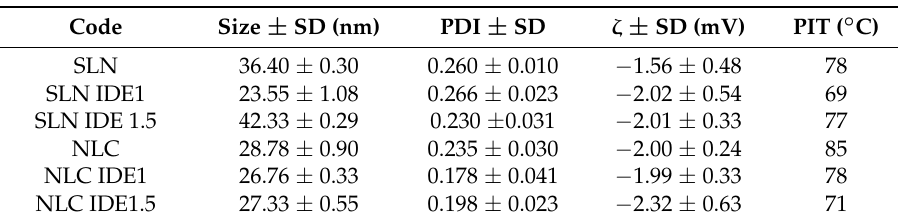
Table 2. Mean size (size), polydispersity index (PDI), zeta potential ( ζ ), and phase inversion temperature (PIT) of unloaded and IDE-loaded SLN and NLC. IDE = idebenone, SLN = solid lipid nanoparticles, NLC = nanostructured lipid carriers. Values are expressed as mean ± standard deviation (SD).